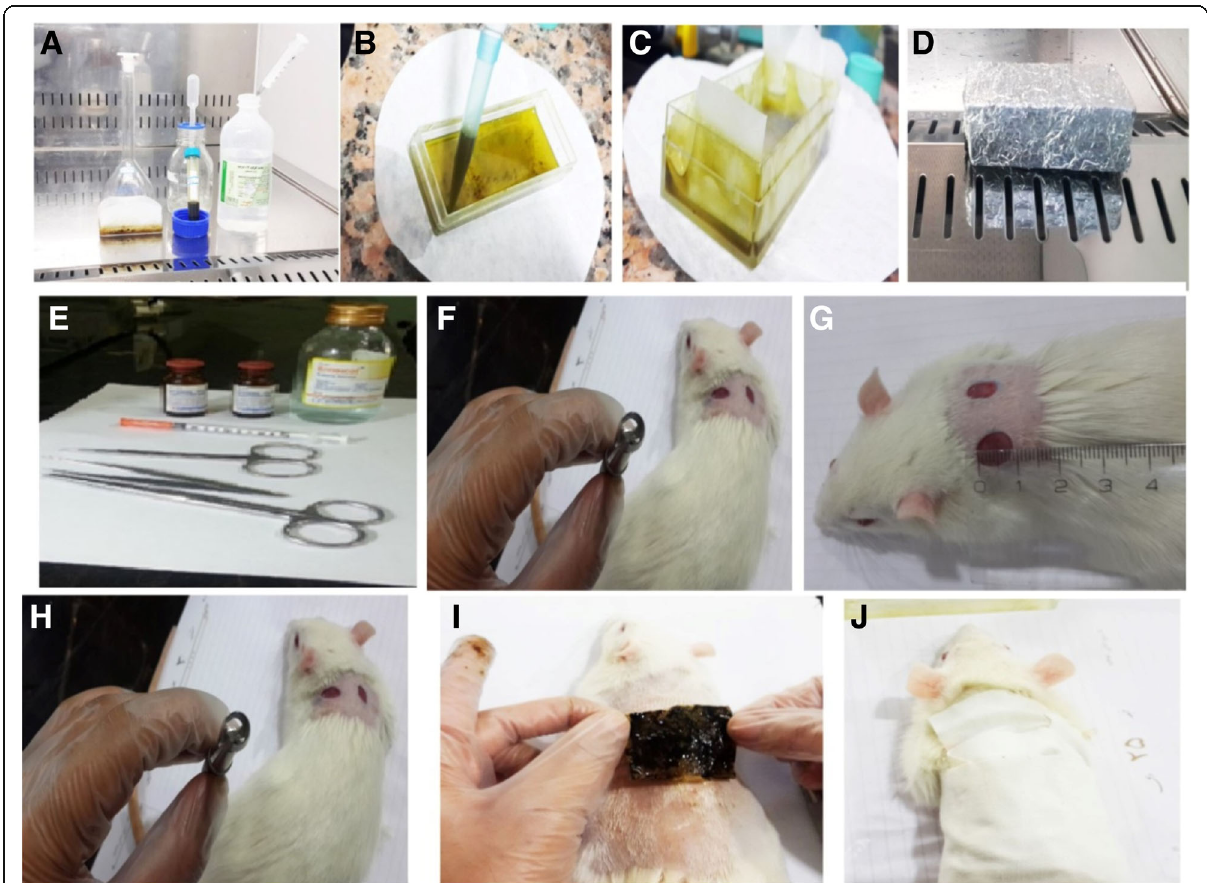
Fig. 4 a – d Preparation of alginate hydrogel and Satureja khuzistanica . e – h The rats were prepared for surgery and the wound was cut in the form of 1 cm circular diameter by using biopsy punch in three layers of the skin (dermis, epidermis, and hypodermis). i , j Wound along with alginate hydrogel dressing and ethanolic extract of Satureja khuzistanica